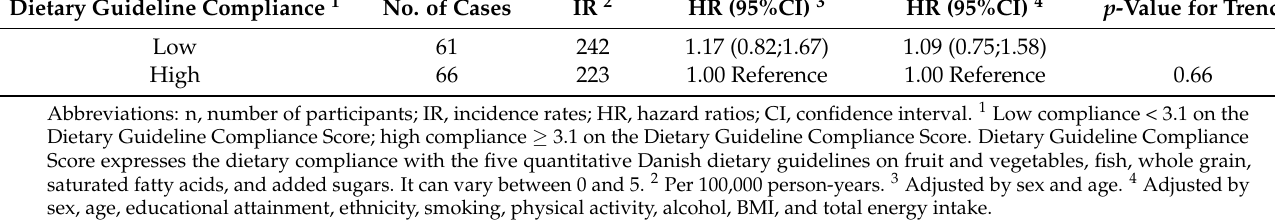
Table 5. Association between dietary guideline compliance and risk of colorectal cancer, n = 6282. Dietary Guideline Compliance 1